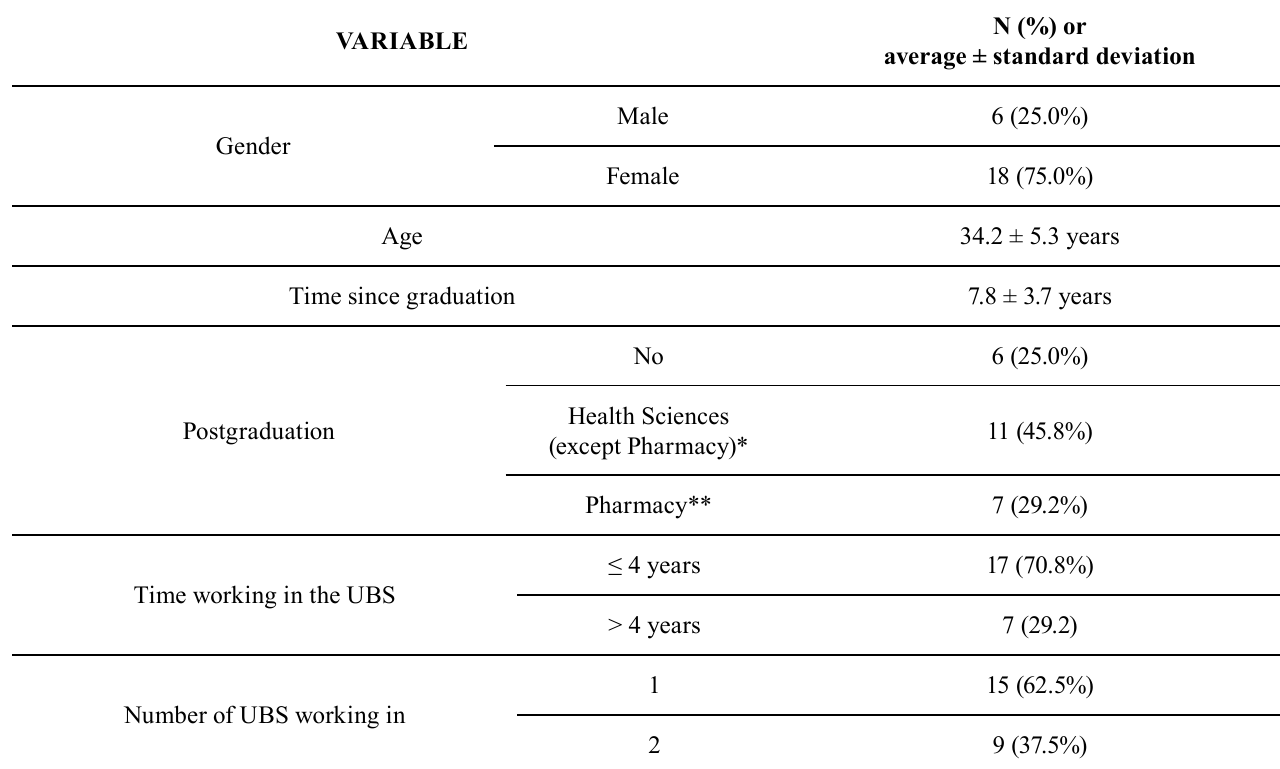
TABLE I – C haracterization of the pharmacists working in primary health centers (UBS) of São Bernardo do Campo,